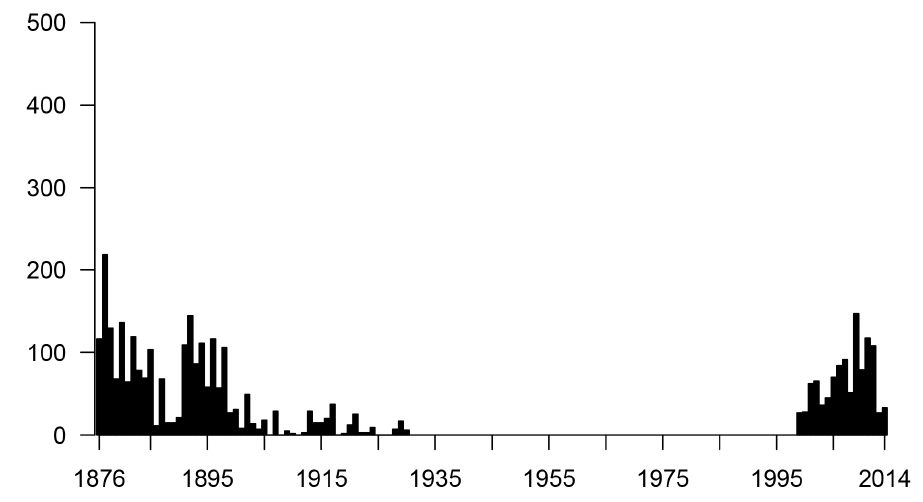
Figure 11. Illustration of the total number of livestock depredated by carnivores per year, 1876–1930 and 1998–2014, in the county of Dalarna. Sources: Swedish National Forest Service and the Wildlife Damage Centre. Please note that there are no records of livestock killed for the years 1931 to 1998. Table 2. The average depredation rates in Jämtland and Dalarna for cattle and sheep (the numbers of depredated animals divided by the total number of livestock). Two separate time periods: 1876–1891 killed by wolves (24 cattle and 529 sheep, compared to 18 cattle and 312 sheep killed by bears). represents the historical time when livestock were abundant and strenuous efforts were made to hunt carnivores, while the recent period, 1999–2014, represents increasing numbers of carnivores and a stable during the late nineteenth century. Since the return of the carnivores, the situation is reversed and number of